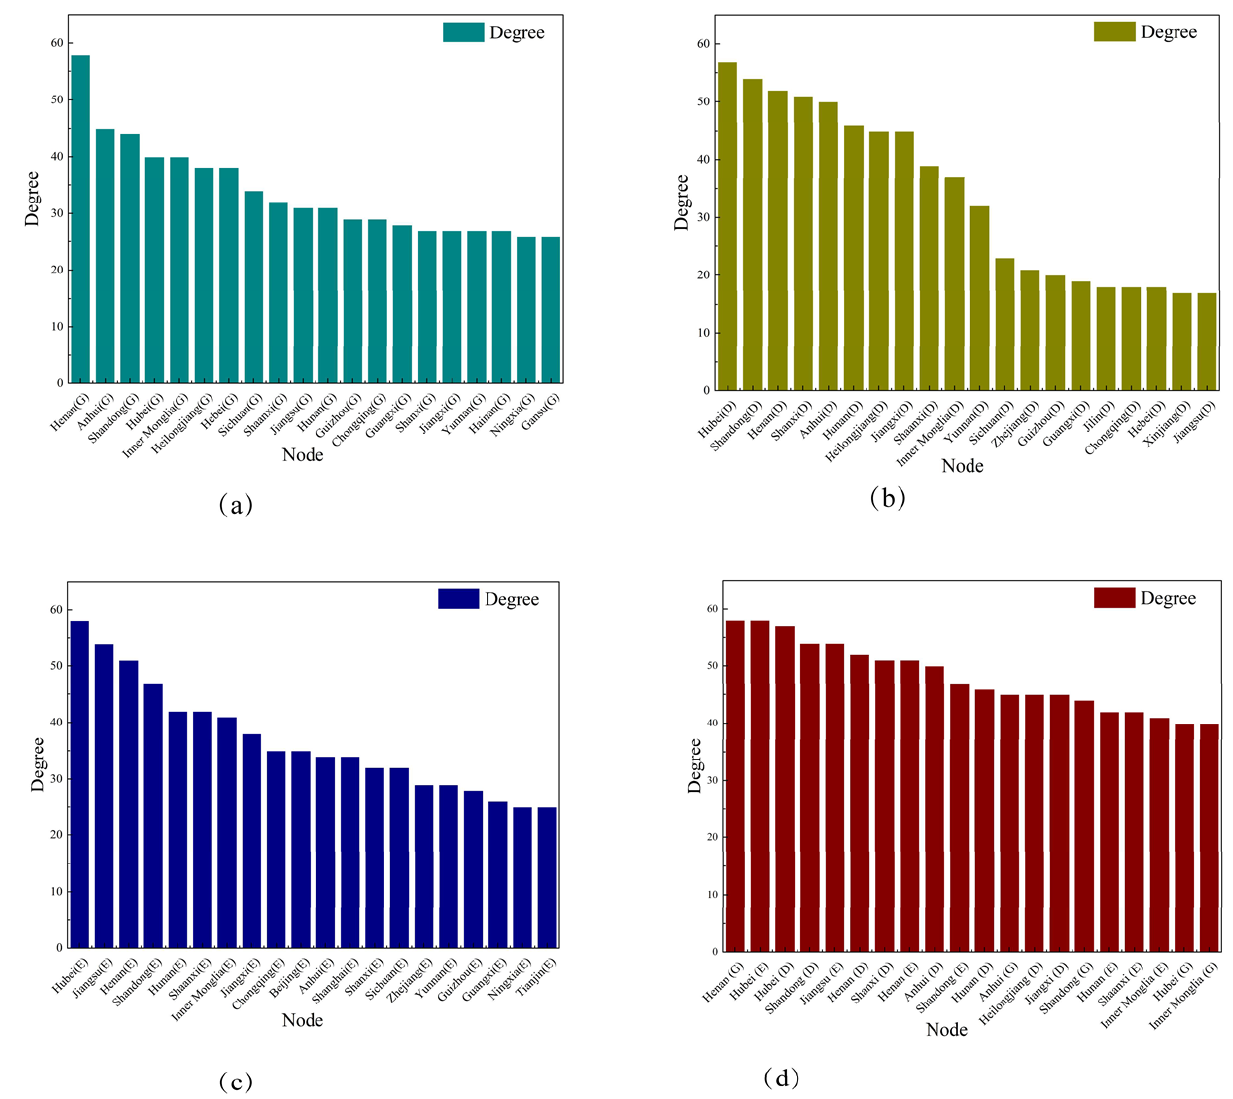
Figure 3. Top 20 nodes in terms of degree value in the networks. ( a ) Grain layer; ( b ) Disaster layer; ( c ) Economy layer; ( d ) The grain-disaster-economy multilayer. (The nodes with the top 20 by degree values are selected in the corresponding network